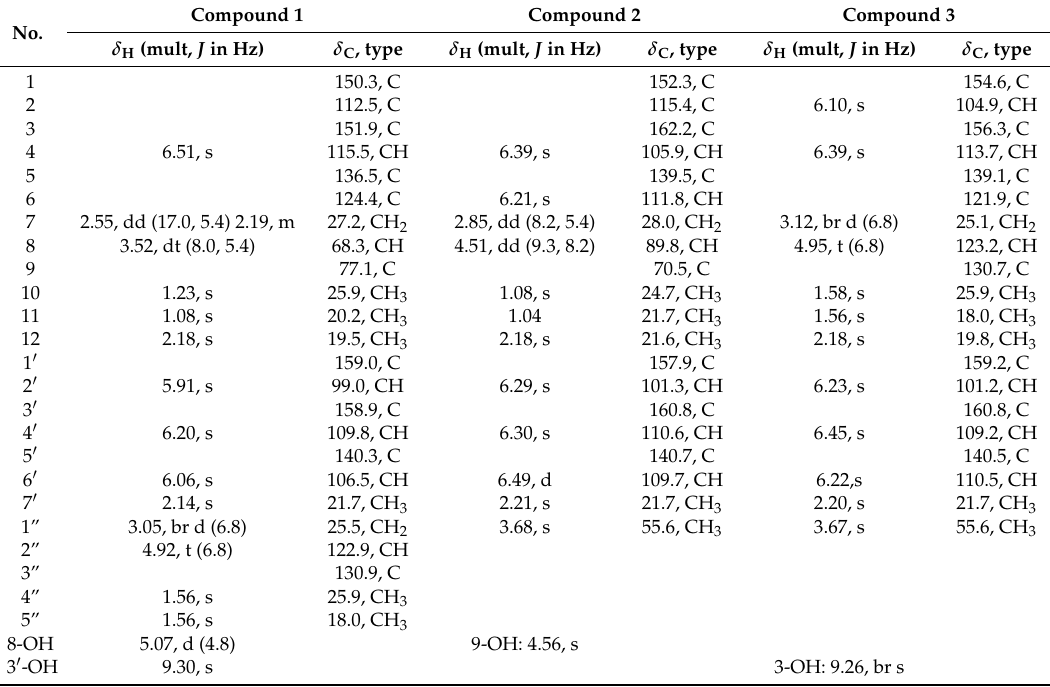
Table 1. 1 H (500 MHz) and 13 C-NMR (125 MHz) data of compounds 1 – 3 in DMSO- d 6